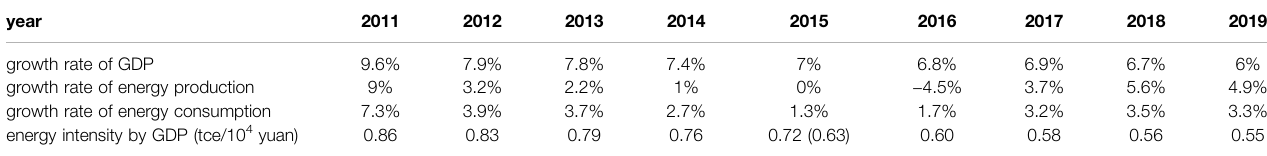
TABLE 1 | Growth rate of energy production, energy consumption and GDP, and the energy intensity by GDP in China during 2011 – 2019. year growth rate of GDP